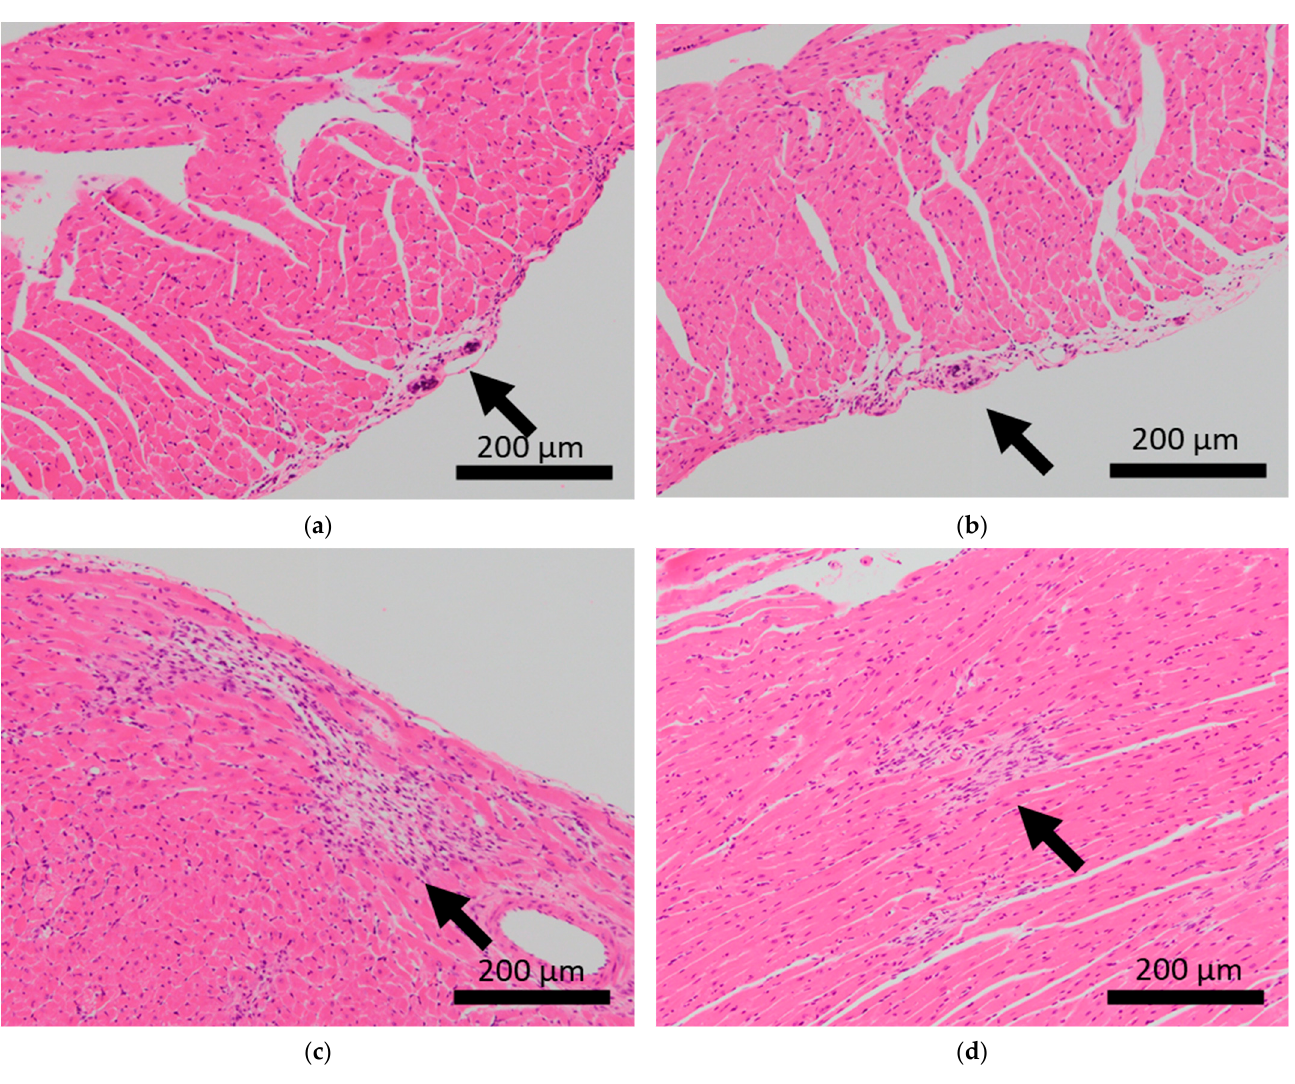
Figure 2. Histopathological features of the hearts of BALB/c mice. Arrows indicate calcification of the epicardium in the hearts of control mice ( a,b ), and fibrosis in mice subjected to sCSDS ( c,d ).